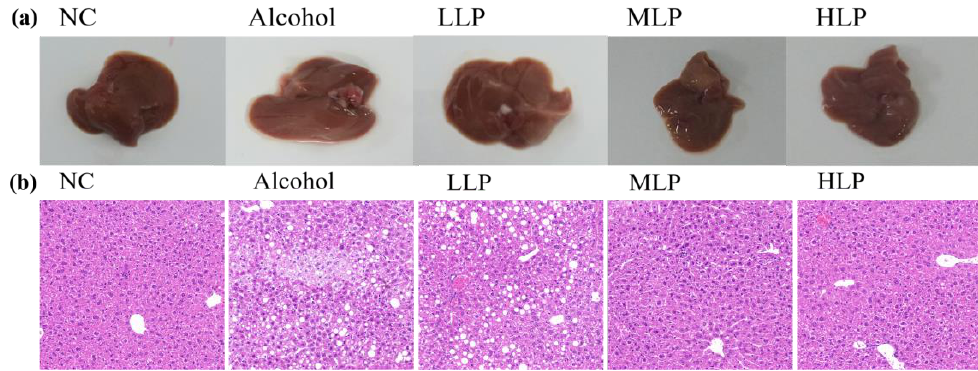
Figure 3. Effects of L. plantarum J26 on liver histopathology in liver of mice. ( a ): anatomical morphology of liver tissue; ( b ): hepatic histopathological alterations (H&E staining, magnification ×200). NC, normal control; LLP, low-dose L. plantarum J26; MLP, medium-dose L. plantarum J26; HLP, high-dose L. plantarum J26.